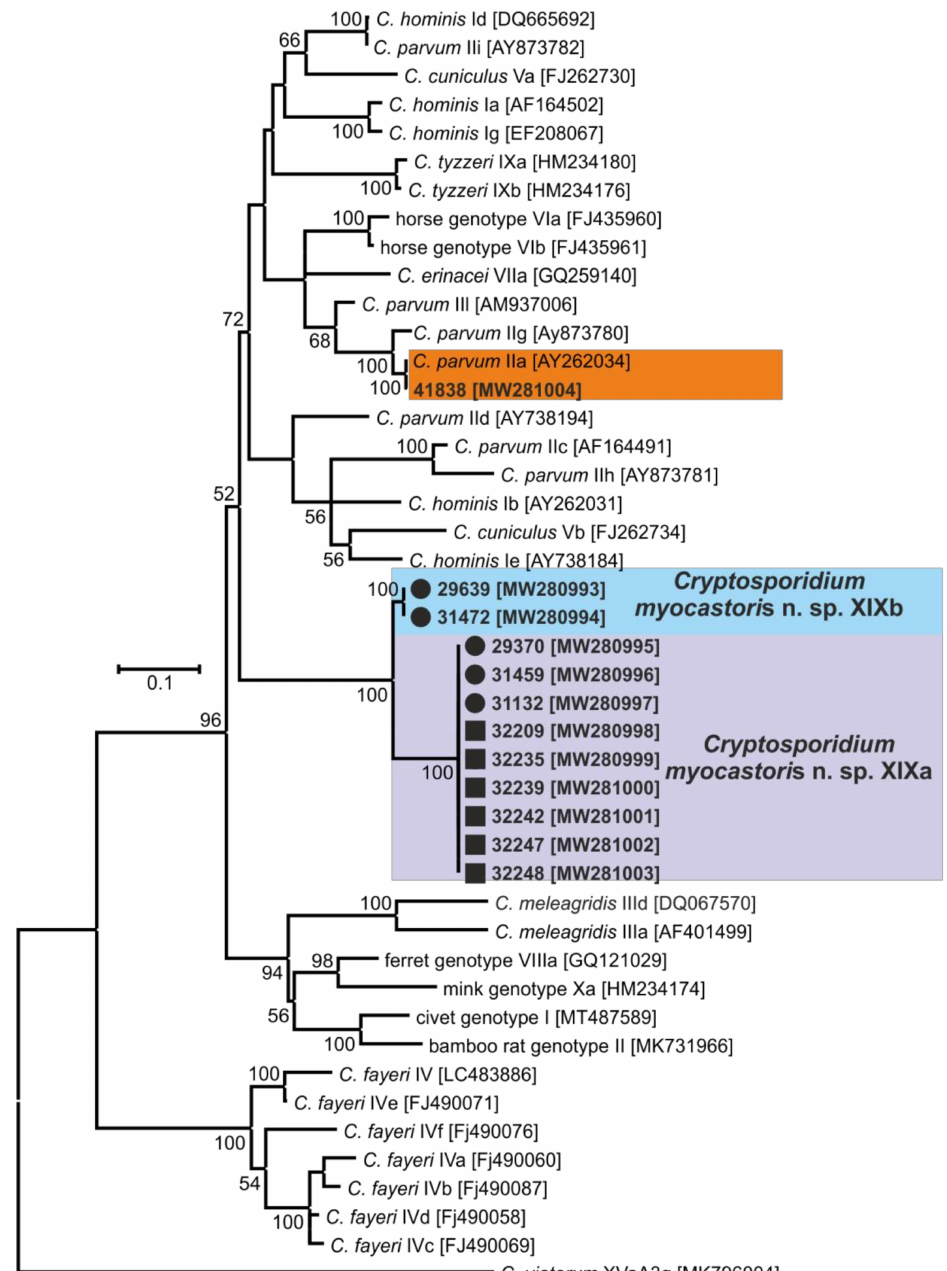
Figure 5. Maximum likelihood tree based on 60 kDa glycoprotein ( gp60 ) gene sequences of Cryp- tosporidium spp., including sequences obtained in this study (bolded and highlighted). The alignment contained 1206 base positions in the final dataset. Numbers at the nodes represent the boot strap values with more than 50% boot strap support from 1000 pseudo replicates. The branch length scale bar, indicating the number of substitutions per site, is given in the tree. Sequences from this study are identified by an isolate number (e.g., 32247). Black circles and squares indicate natural and experimental infections,